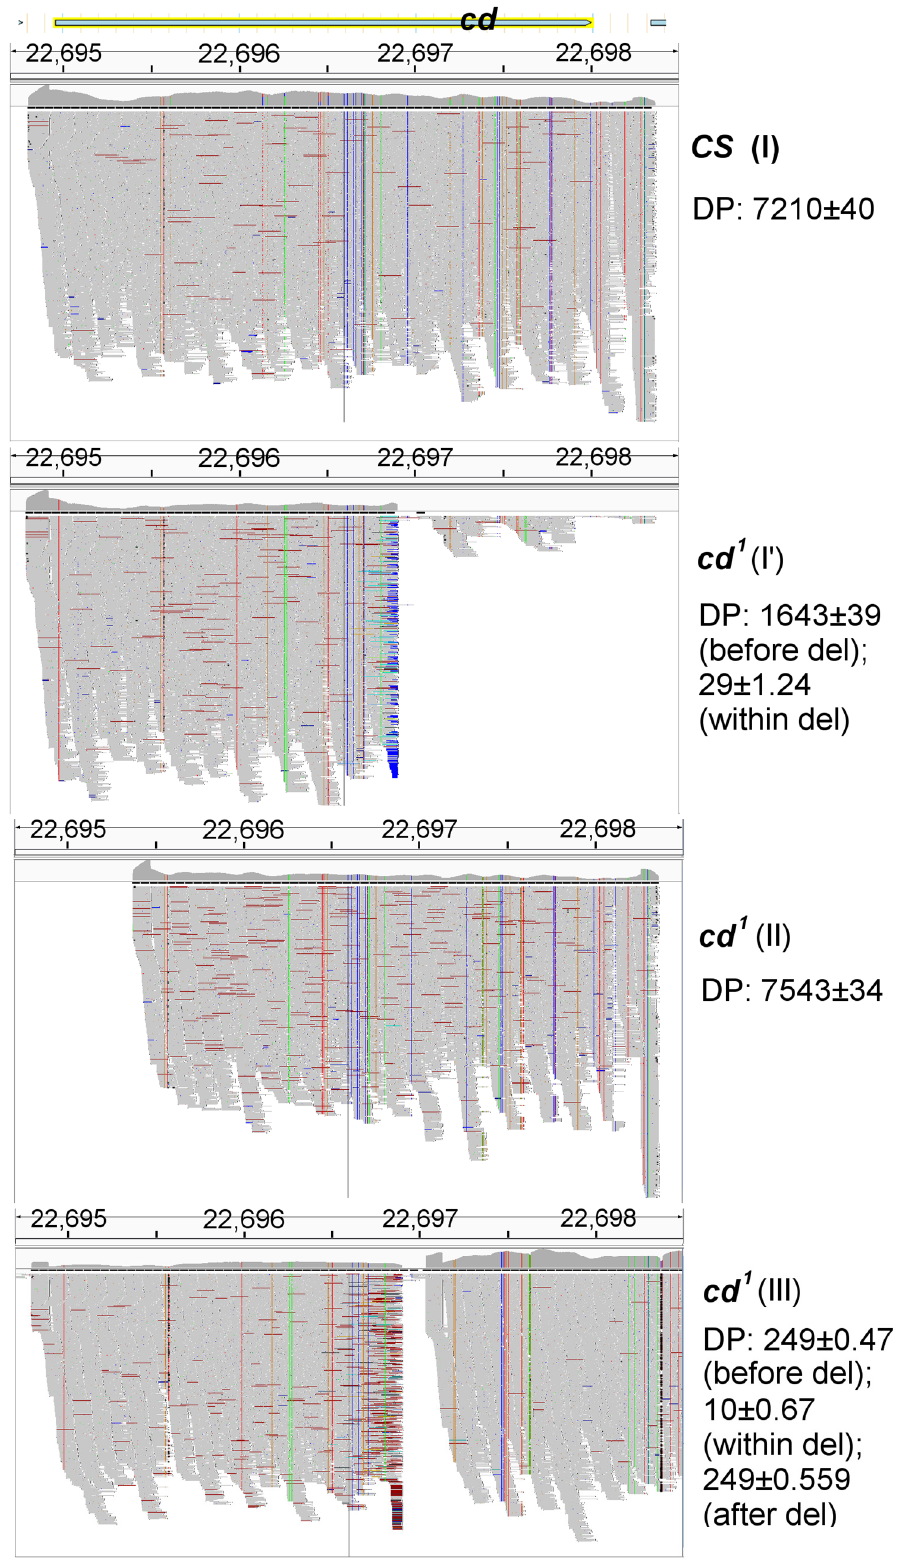
Figure 3. Aligned reads of the cd gene amplicons. Reads are shown in grey. Single nucleotide polymorphisms (SNPs) and misaligned reads are shown in other colors. DP—sequencing depth, del—deletion. Positions on the X chromosome are shown in kb. The amplicons are indicated by Roman numerals.